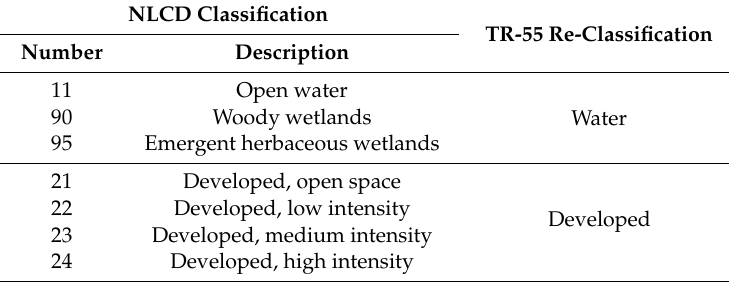
Table A1. Reclassification of NLCD land cover types for curve number